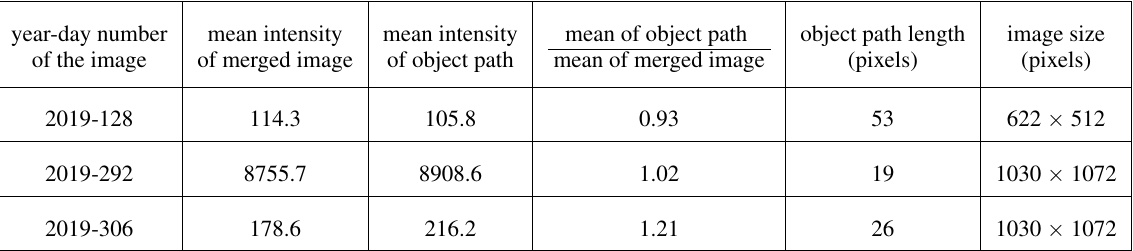
Table 1. Information of the FITS uint16 images